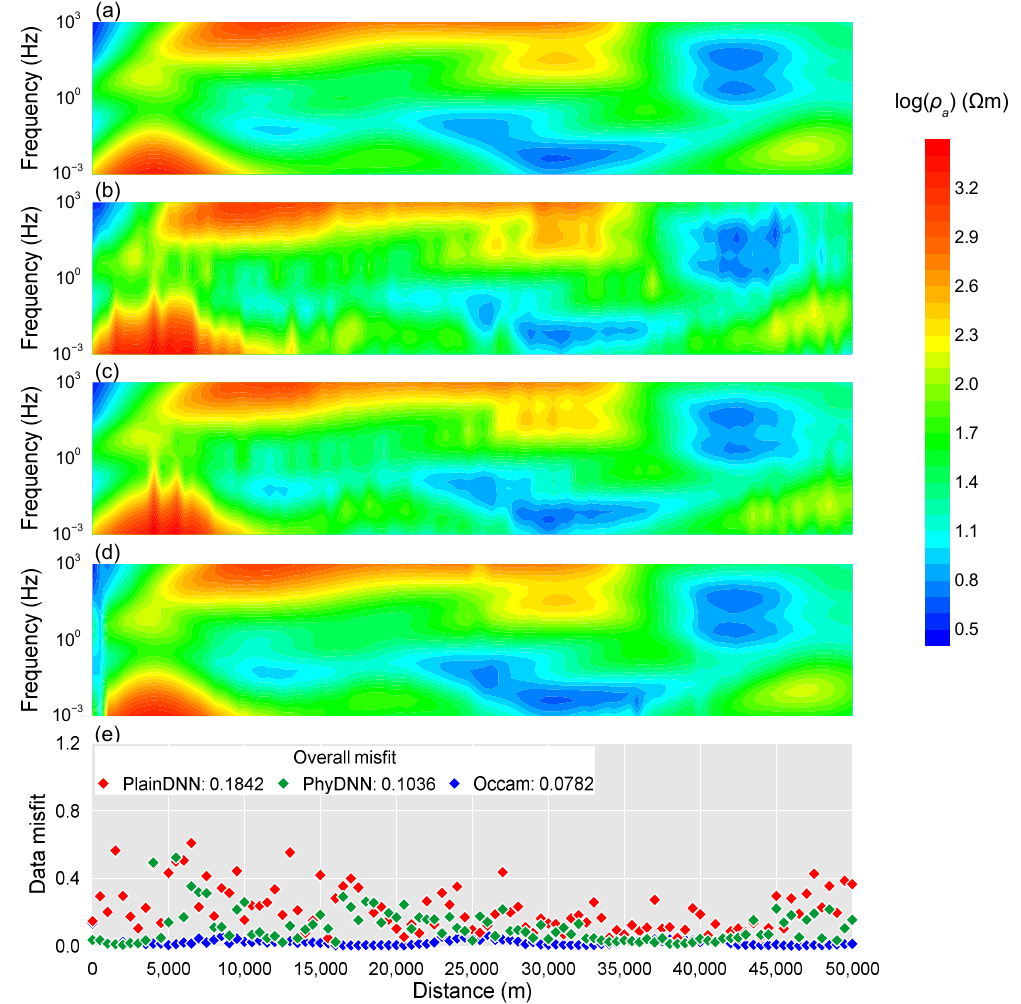
Figure 15. Comparison of the corresponding simulated apparent resistivity sections of the models shown in Figure 14. ( a–d ) are the real apparent resistivity, the simulated apparent resistivity of the PlainDNN, PhyDNN and Occam, respectively. ( e ) shows the individual data misfit for all sites and the overall data misfit of the whole model.